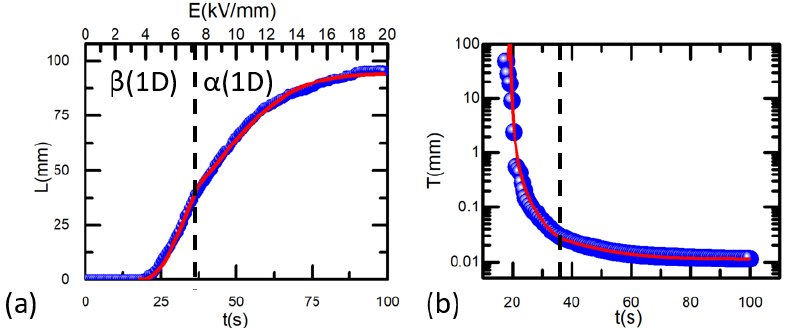
Figure 6. Time dependencies of the domain structure parameters during switching in increasing field: ( a ) the total length of the stripe domains and ( b ) the effective period of the domain structure, fitted by Equation (7) and Equation (8), respectively.